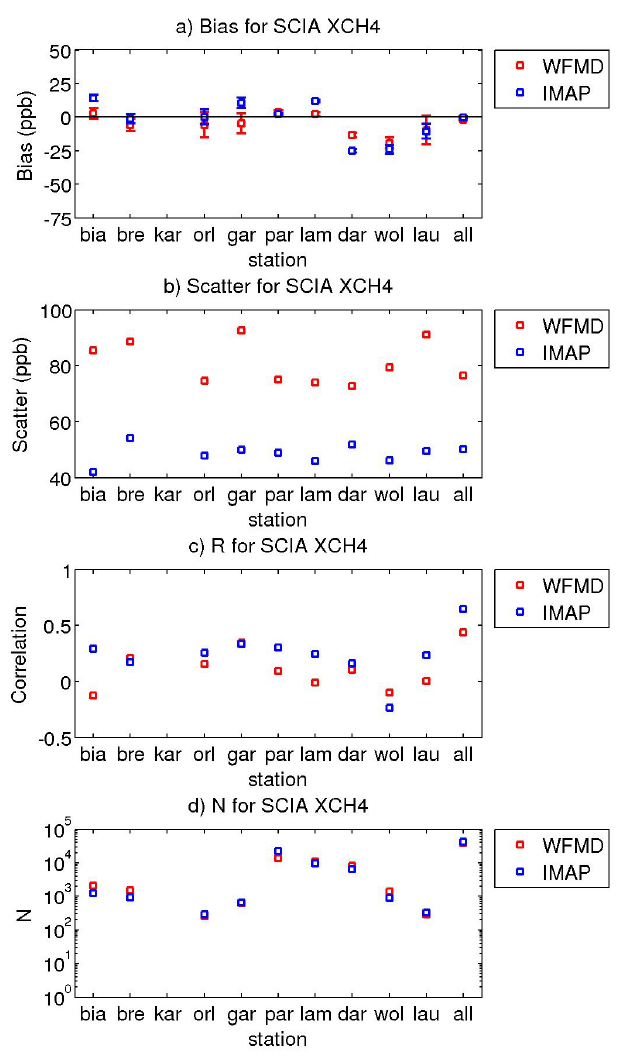
Figure 9. SCIAMACHY XCH 4 bias (a) , scatter (b) , correlation (c) and number of data pairs (d) , for all individual TCCON stations and all data combined.